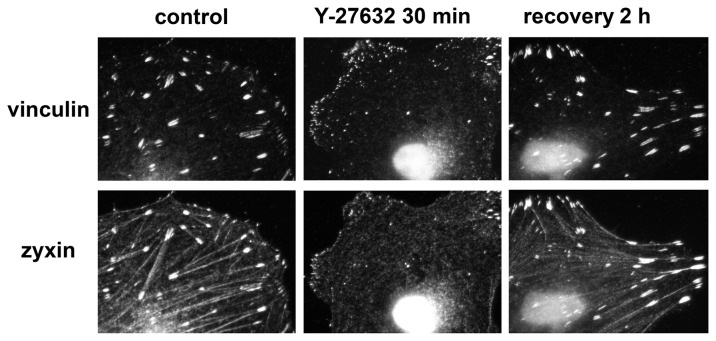
Reversibility of the effect of Y-27632 on cell morphology.Images of Y-27632-treated HeLa JW cells were taken prior to addition of the drug, after 30 min incubation with 10 µM Y-27632, and 2 h after the drug was washed off. The effect of Y-27632 on cell morphology was reversible, as cells regained normal morphology within 2 hours of reagent withdrawal.